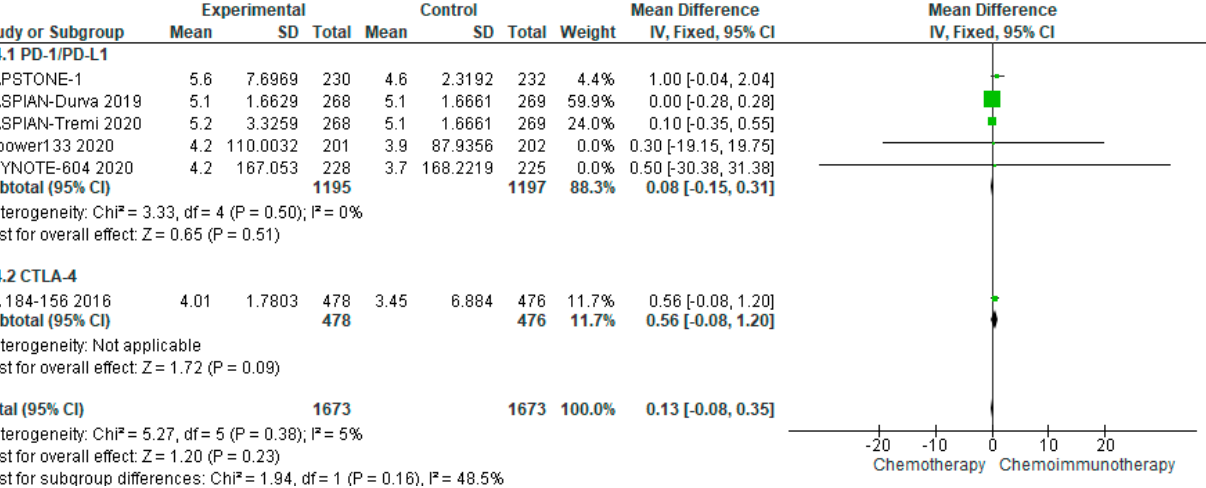
Figure 3. Forest Plot of risk ratios for ORR in patients with ES-SCLC and treated with chemo-ICI versus standard chemotherapy. PD–1/PD–L1, programmed death (ligand) –1; CTLA–4, cytotoxic T- lymphocyte-associated protein 4; HR, hazard ratio; CI, confidence interval; M-H, Mantel–Haenszel.